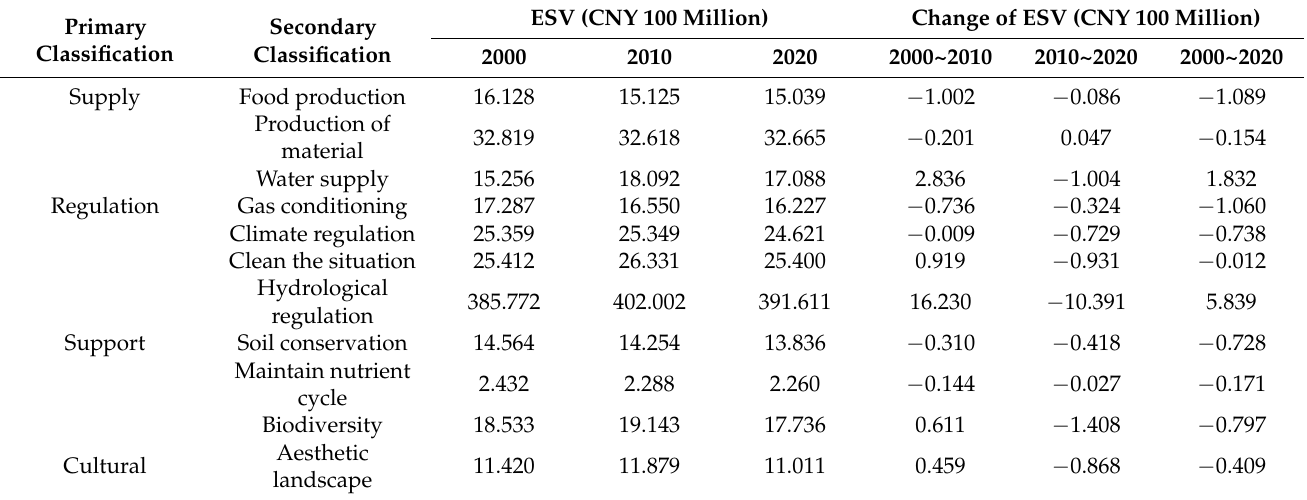
Table 6. Changes in the structure of ESVs in Wuhan during